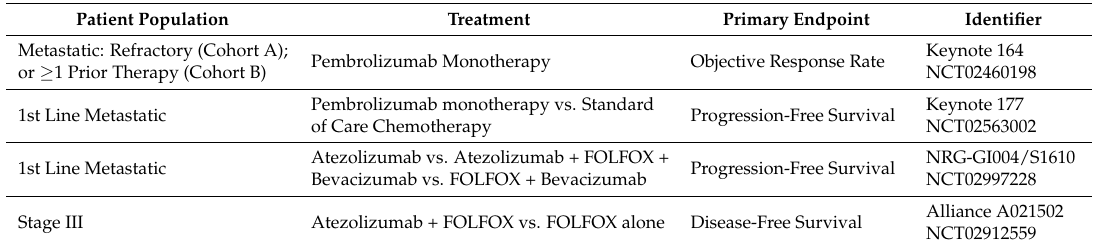
Table 2. Key ongoing/planned trials in MSI-H